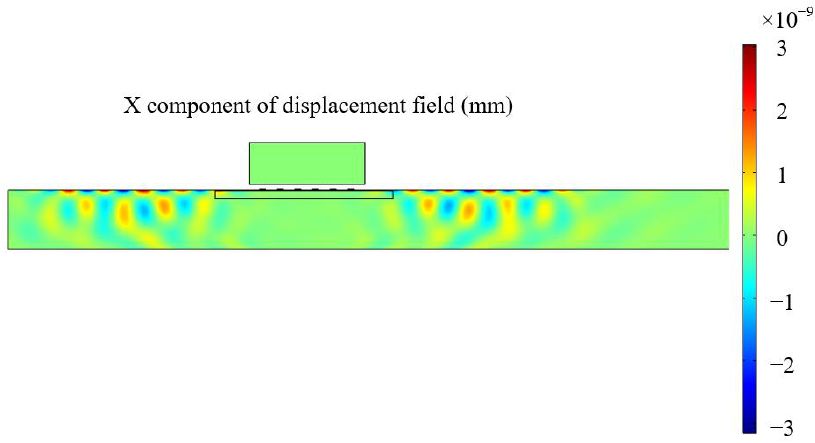
Figure 16. X -direction component of surface wave (in-plane displacement).